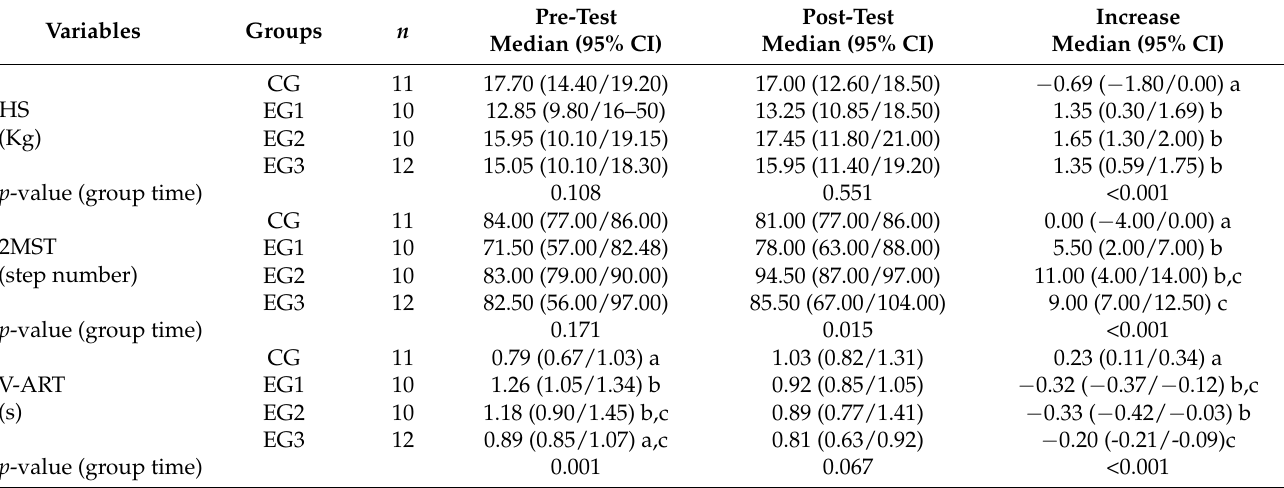
Table 3. Physical variables in pre- and post-test.